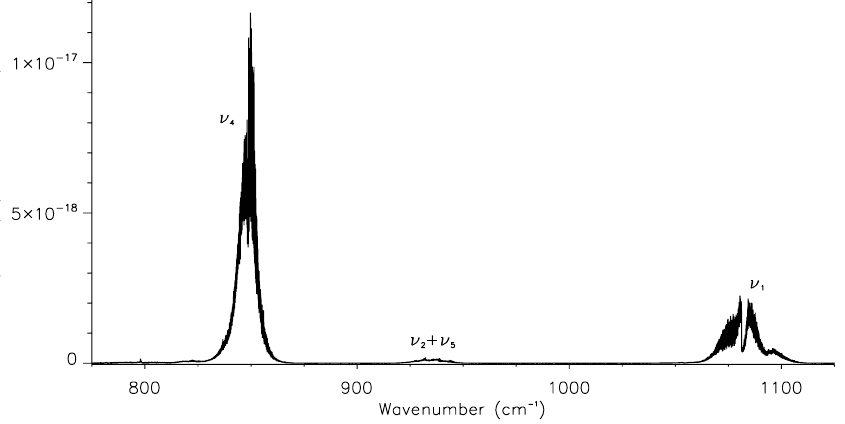
Figure 1. The absorption cross section of trichlorofluoromethane/dry synthetic air at 191.7K and 7.535Torr (this work), with vibrational band assignments for the main band systems in the 710–1290cm − 1 spectral region.